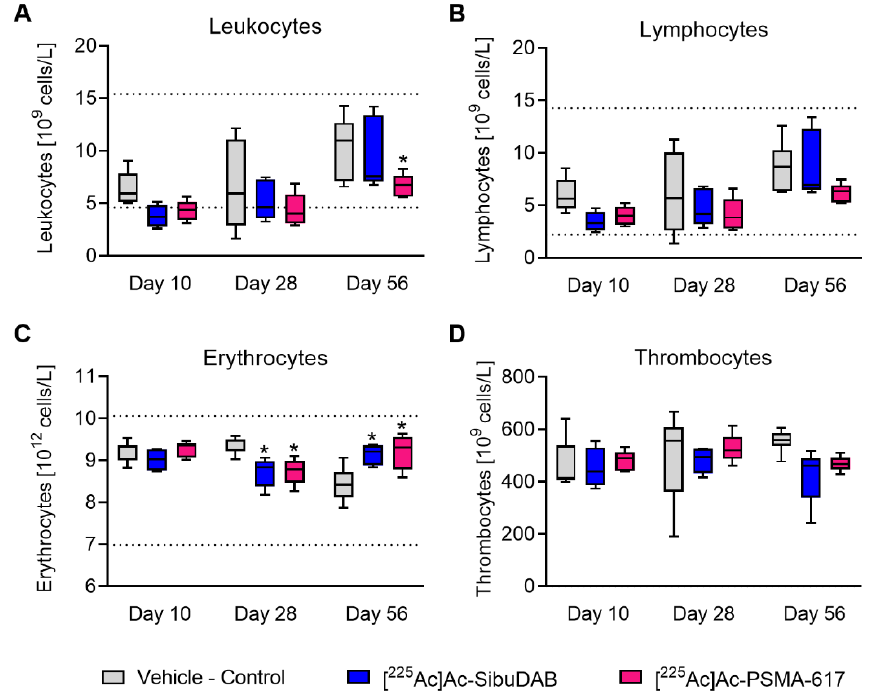
Figure 3. Hematological analysis of the blood from mice ( n = 4–7) at defined days after treatment with vehicle or 30 kBq of either PSMA radioligand. ( A ) Leukocyte counts; ( B ) Lymphocyte counts; ( C ) Erythrocyte counts; ( D ) Thrombocyte counts. Values that were significantly different from those of control mice were indicated with an asterisk (*). The dotted lines represent reference values for healthy female FVB mice previously reported by Schneck et al. [30] .